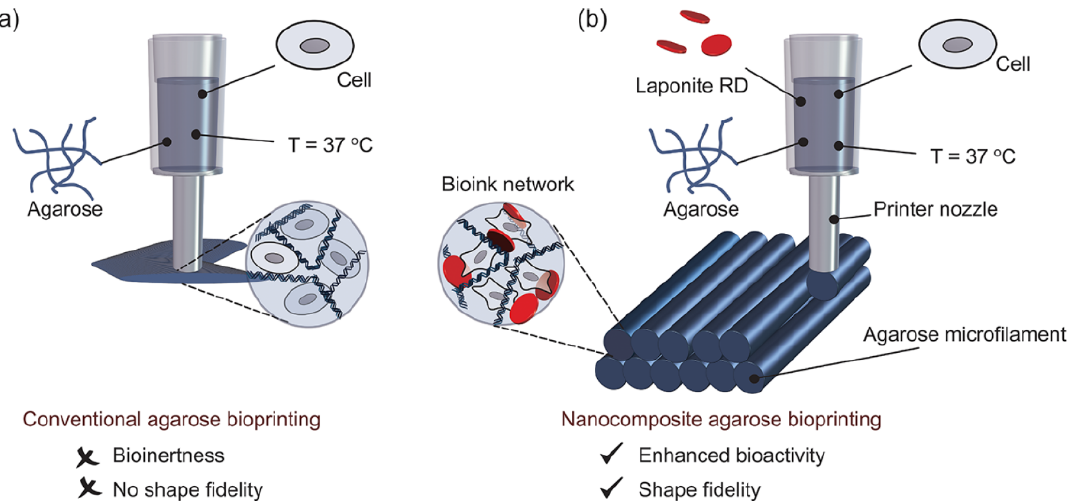
Figure 9 . Schematic representation of: ( a ) conventional bioprinting (without a nanofiller); and ( b ) nanocomposite bioprinting, including polymeric bioinks with a nanofiller (laponite clay). (Reprinted with permission from [55]. Copyright 2019, American Chemical Society).